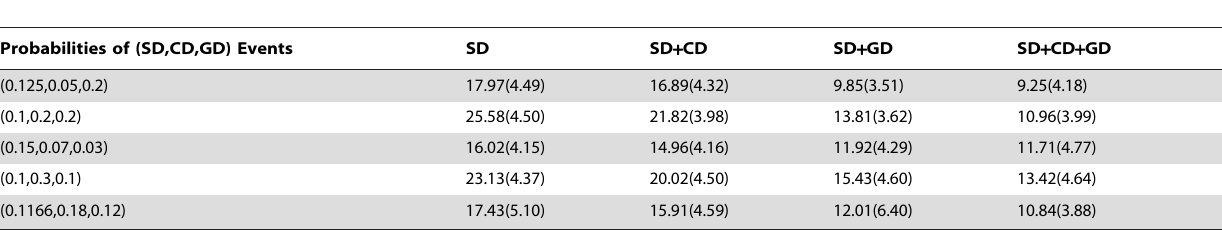
Table 1. Comparison of mean percentage reconstruction error (with standard deviation) of different phylogeny models on simulated data for different combinations of SD, CD and GD event